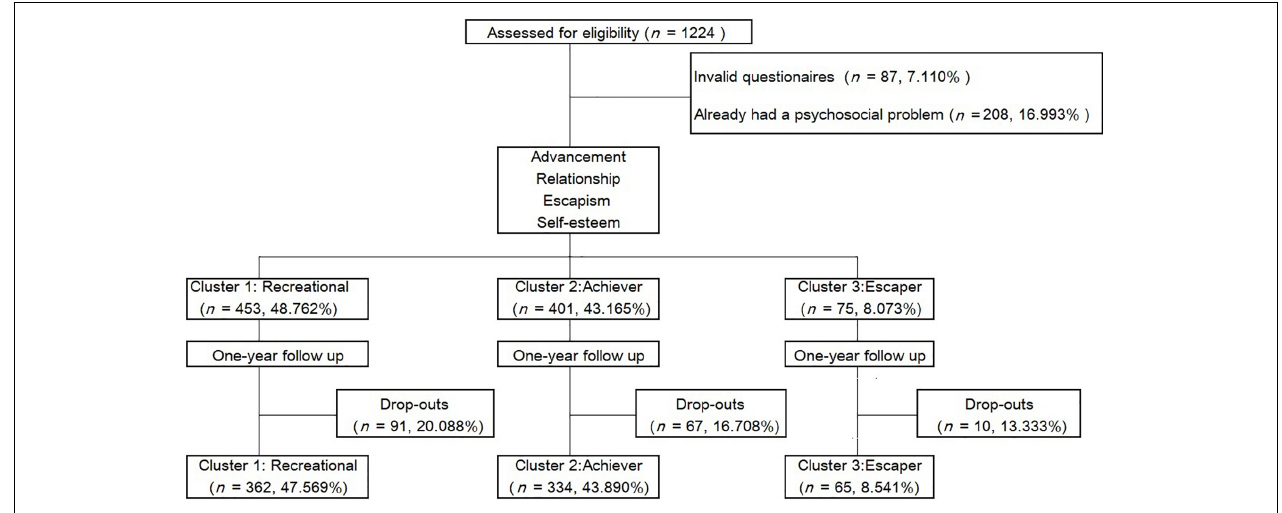
FIGURE 1 | Study flow